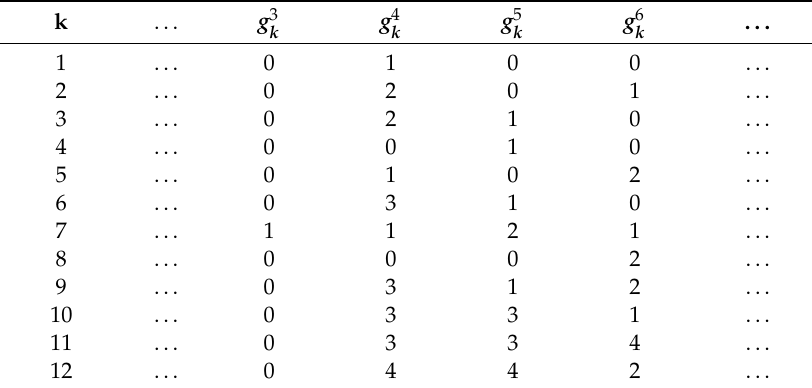
Table 2. New error count for each variable in the error